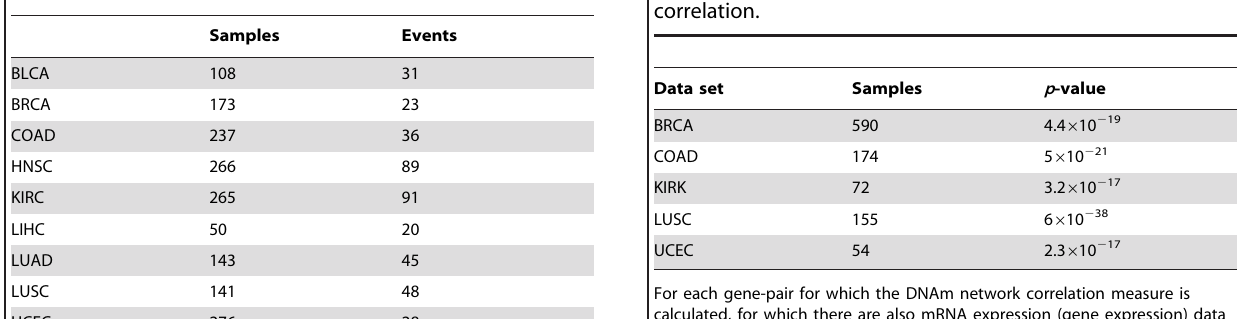
Table 2. Significance of association of the DNAm network correlation measure with gene expression network